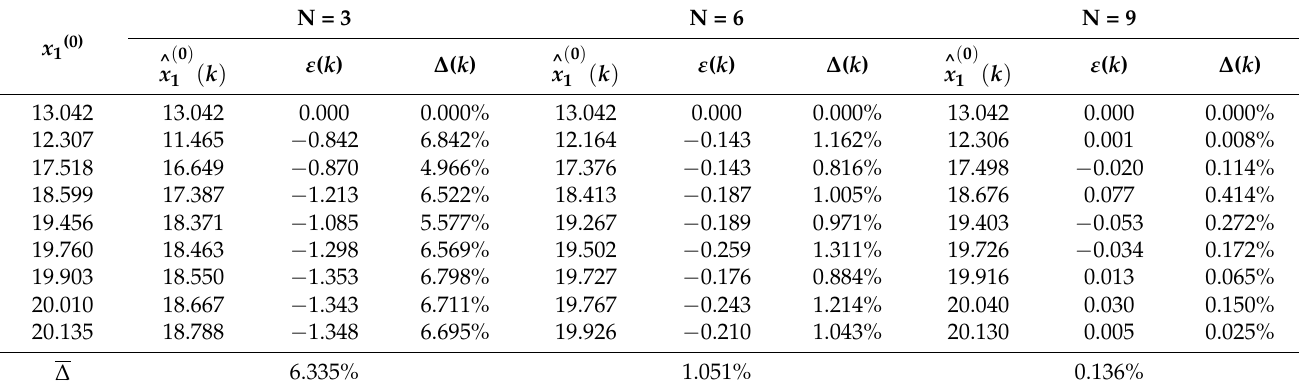
Table 2. Fitting effect of FOBGM with a different number of explanatory variables ( ξ = 0.5).